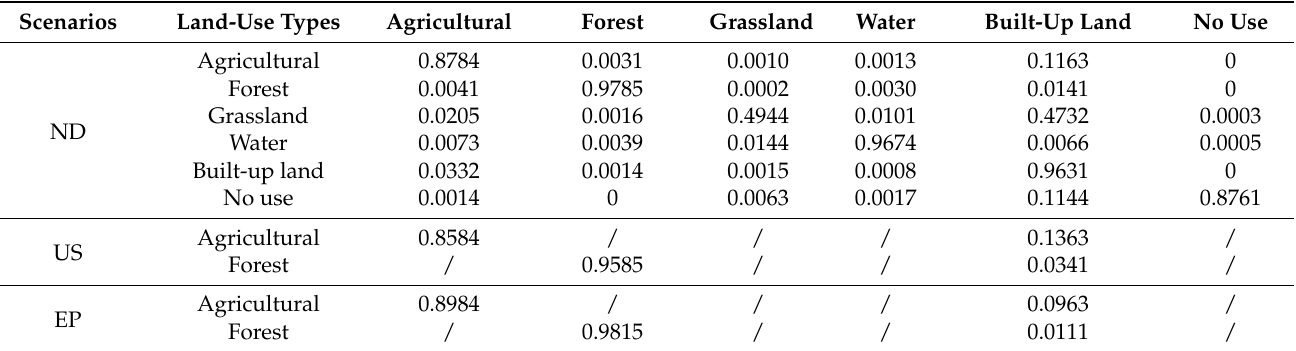
Table 2. Land transition probability matrix under different scenarios from 2015 to 2025 (US and EP omit the same transition probability as